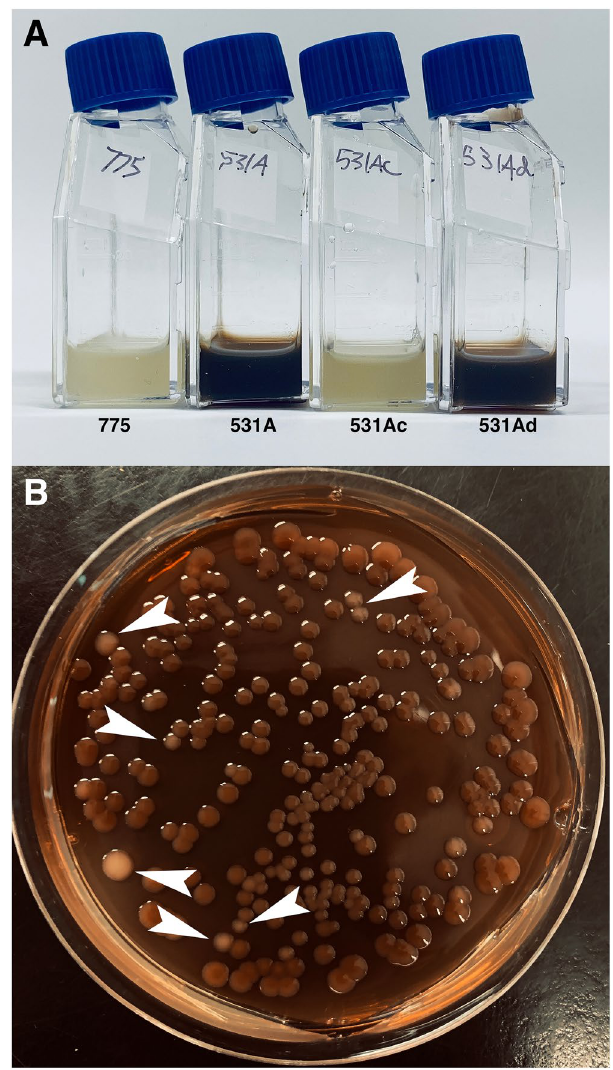
Figure 1. Pigment production in V . anguillarum strains. ( A ) Cultures were carried out in TSBS at 25 °C for 72 h with shaking. ( B ) V . anguillarum 531A was plated in TSAS and incubated at 25 °C for 48 h. The white arrowheads show some of the clear colonies. Variants 531Ac and 531Ad were isolated from a similar